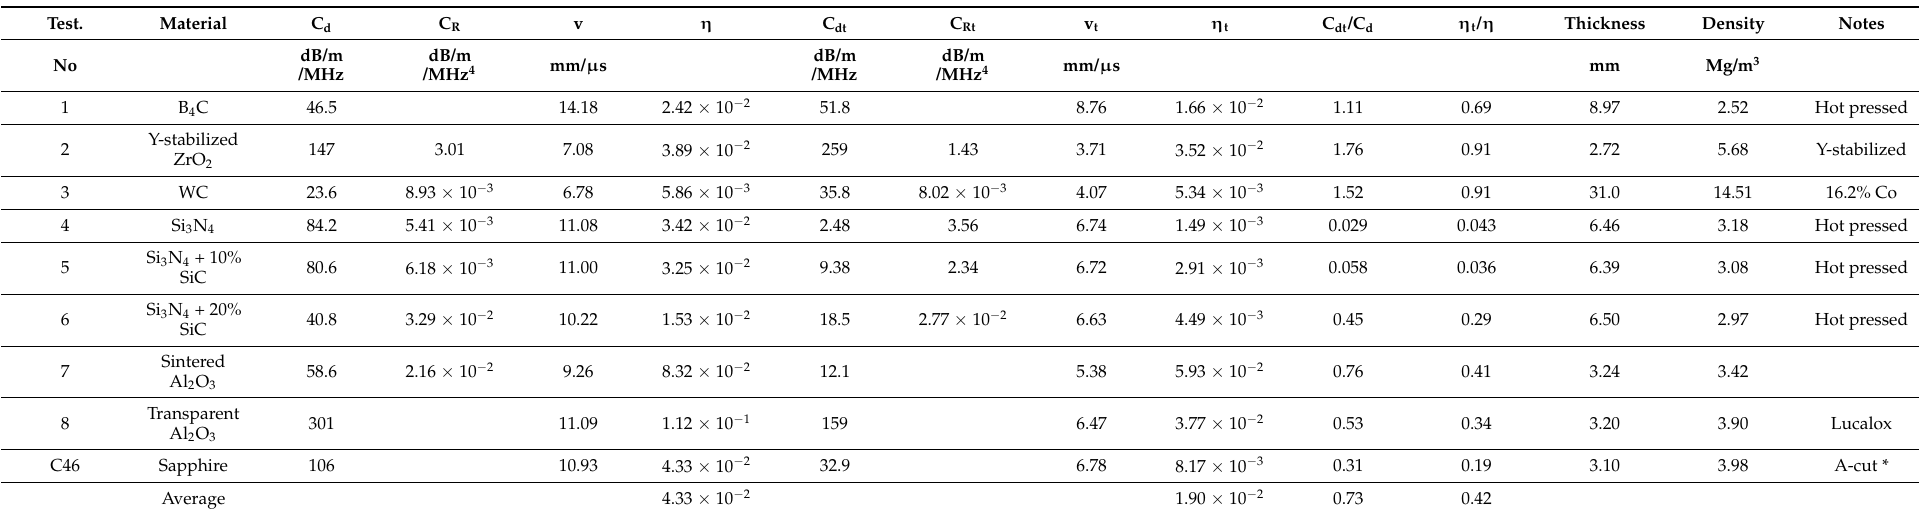
Table 3. Attenuation coefficients of longitudinal and transverse modes of hard